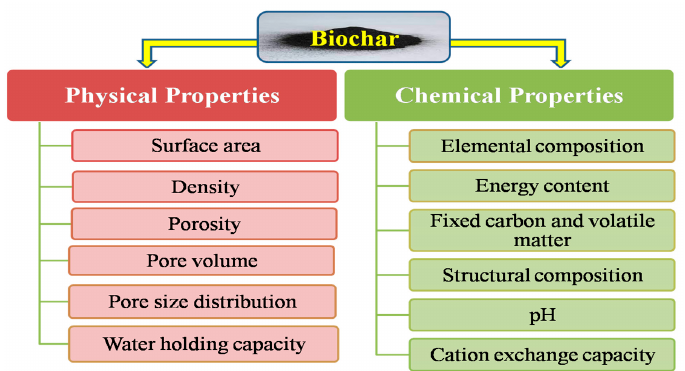
Figure 4. Physiochemical properties of